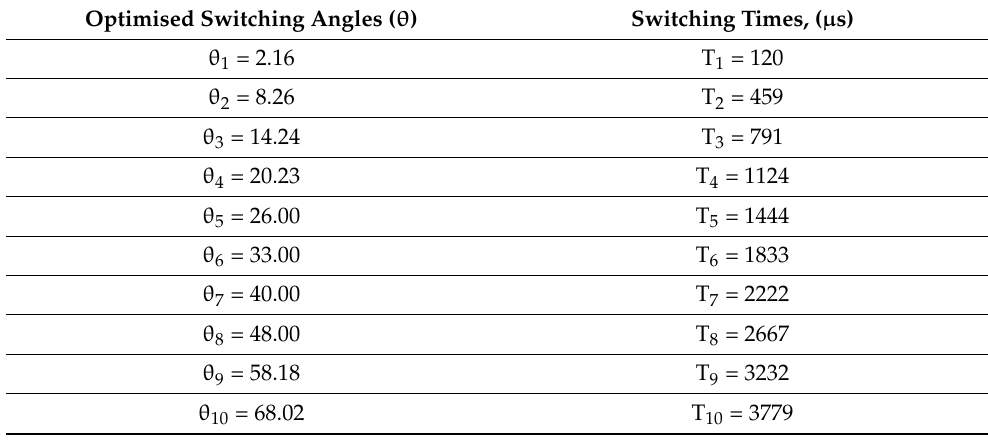
Table 3. Conversion of optimised switching angles ( θ 1 – θ 10 ) to switching times (T 1 –T 10 ).